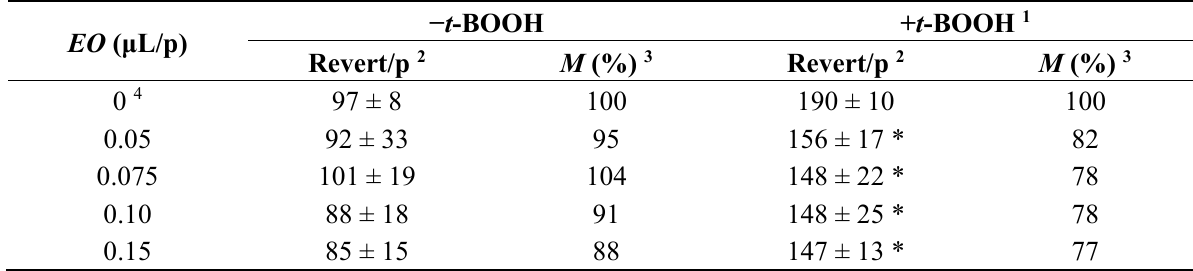
Table 3. Effect of Eucalyptus gunnii essential oil ( EO ) on spontaneous and t -BOOH-induced mutagenesis in E. coli